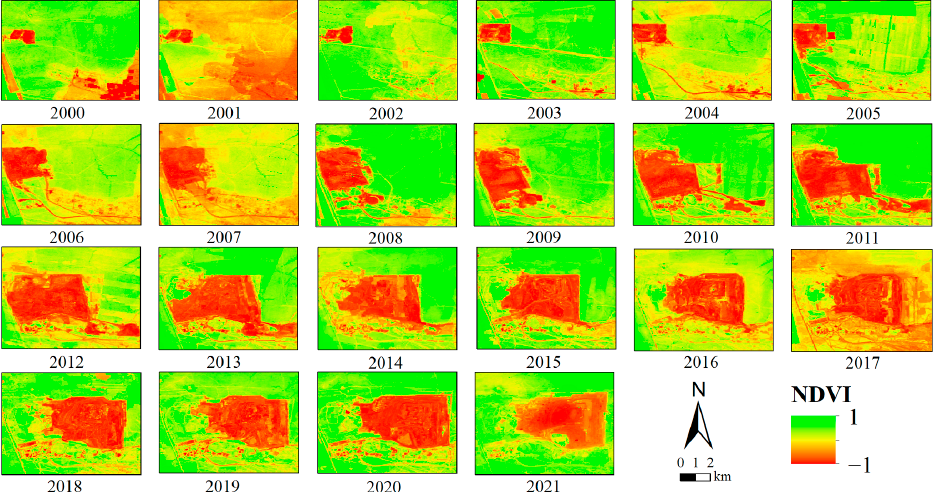
Figure 7. NDVI variation from 2000 to 2021.